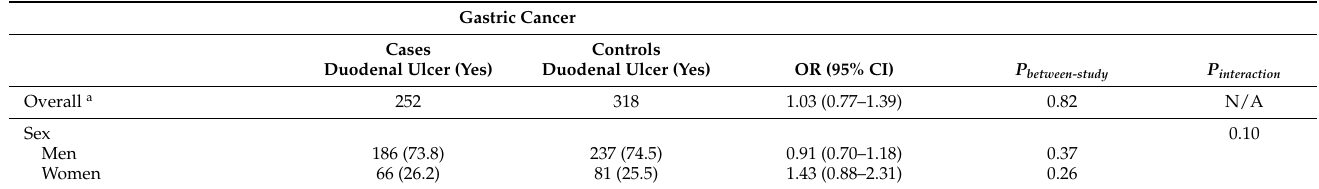
Table 3. Association between Duodenal Ulcer and Gastric Cancer, Stratified by Selected